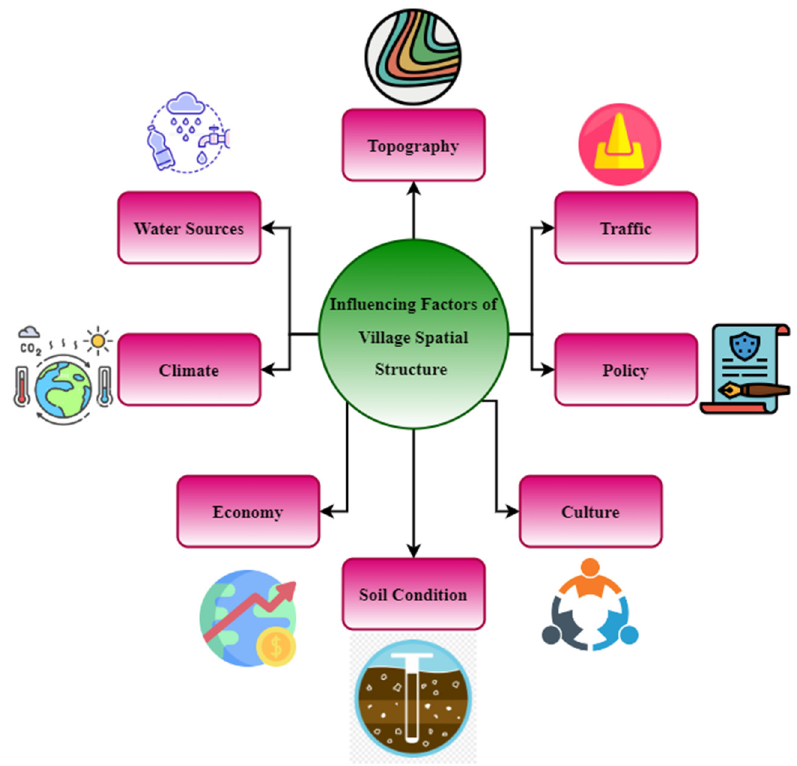
Figure 3. The impact factors of village spatial structure.